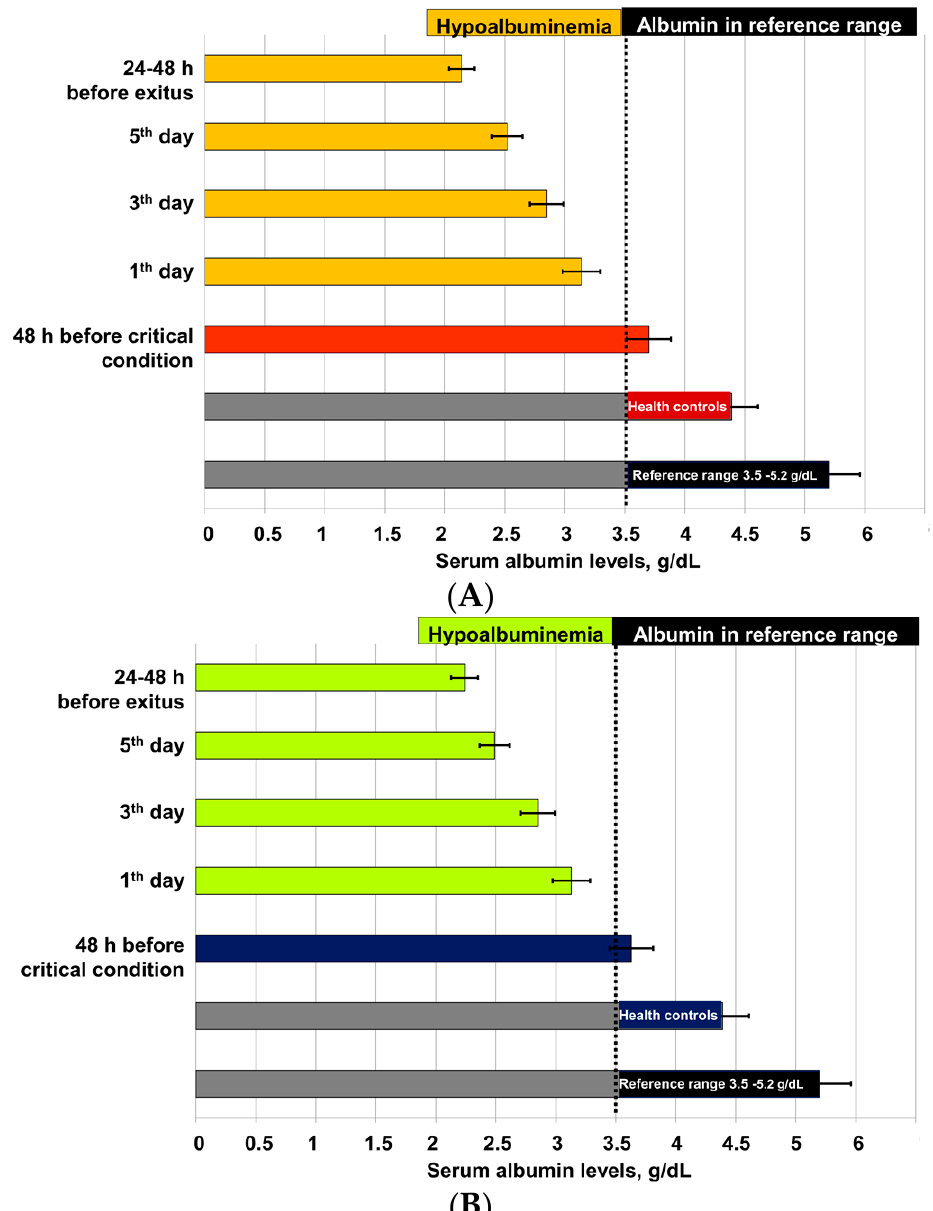
Figure 2. Graphical representation of changes in serum albumin levels in patients with COVID-19 by gender (( A )—females, ( B )—males) measured from the time of admission.